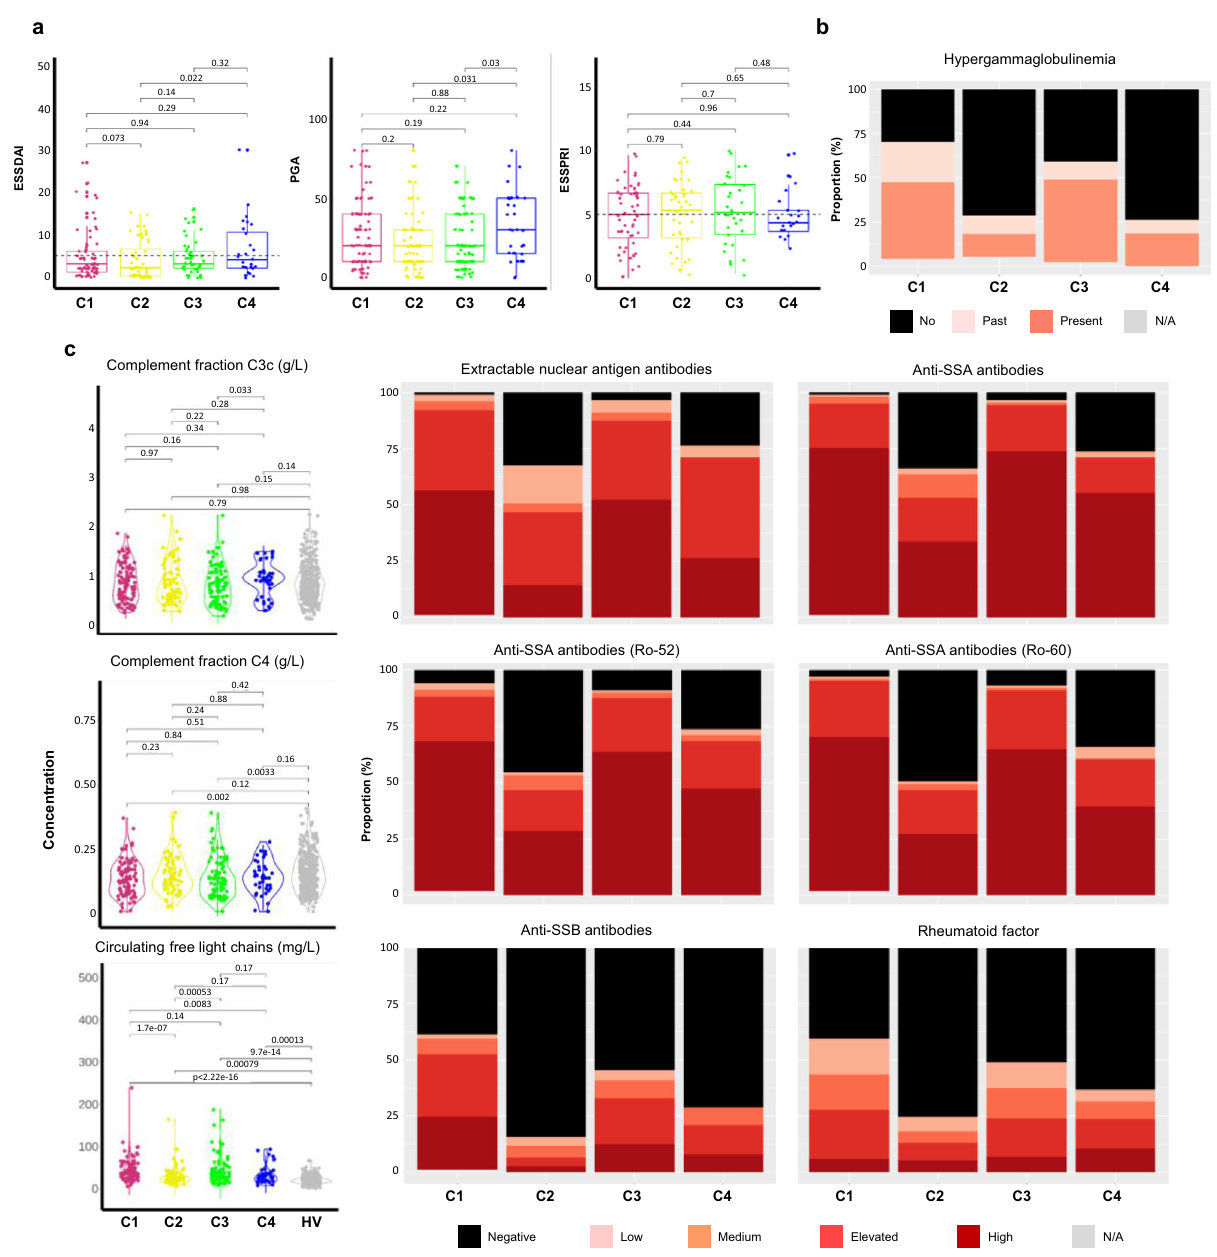
Fig. 7 Disease activity and serological distributions in the 4 clusters. a ESSDAI collected for 193 pSS patients (C1: 70, C2: 52, C3: 44, C4: 27), PGA collected for 286 pSS patients (C1: 94, C2: 71, C3: 85, C4: 36,) and ESSPRI collected for 150 pSS patients (C1: 56, C2: 43, C3: 30, C4: 21) distributions are shown in the 4 clusters. Two-tailed pairwise Wilcoxon-rank sum test results are shown. b The barplot shows the proportion of past (light orange) or present (orange) hypergammaglobulinemia (C1: 97, C2: 73, C3: 86, C4: 38) in each cluster. c Extractable nuclear antigen antibodies, anti-SSA antibodies, anti-SSA antibodies (Ro-52), anti-SSA antibodies (Ro-60), anti-SSB antibodies, rheumatoid factor were performed for 304 pSS patients (C1: 101, C2:77, C3:88, C4:38) and 330 HV and measured in serum, at the same center, using an automated chemiluminescent immunoanalyzer (IDS-iSYS). Barplots show the proportion of concentration level in each cluster (black: negative, light pink: low, orange: medium, red: elevated and dark red: high). Turbidimetry was used for rheumatoid factor (RF), complement fractions C3c and C4 determination and circulating free light chains. Statistical signi fi cance is determined by two-tailed pairwise Wilcoxon-rank sum test. Plots show median with error bars indicating ± interquartile range. Patient and HV distribution according to PGA and biological parameters analyzed variable is described in